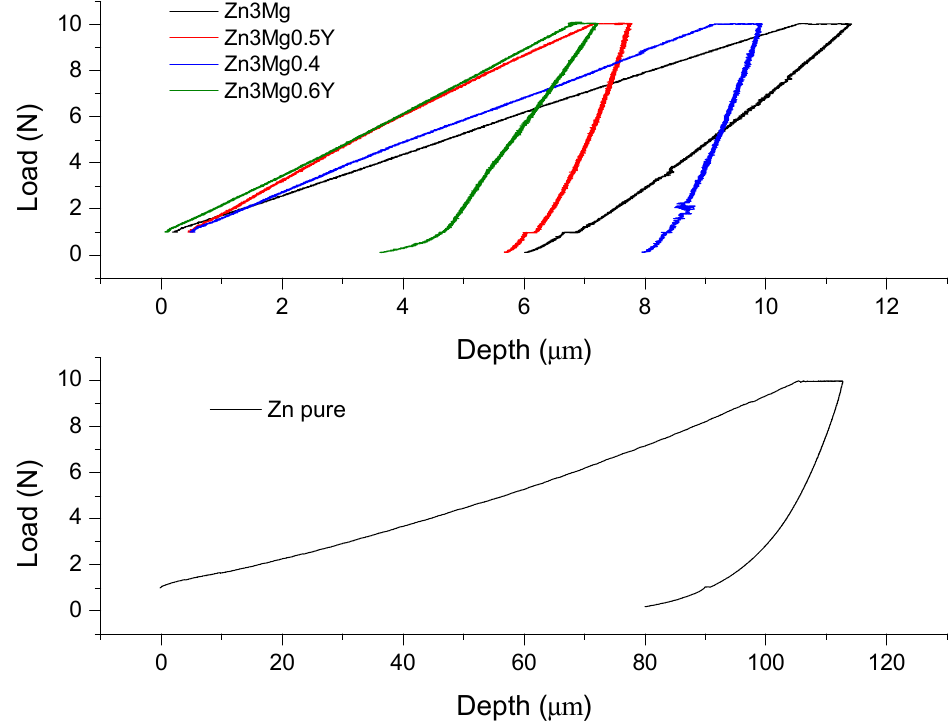
Figure 7. Microhardness experiments pure Zn and Zn-alloy behavior.